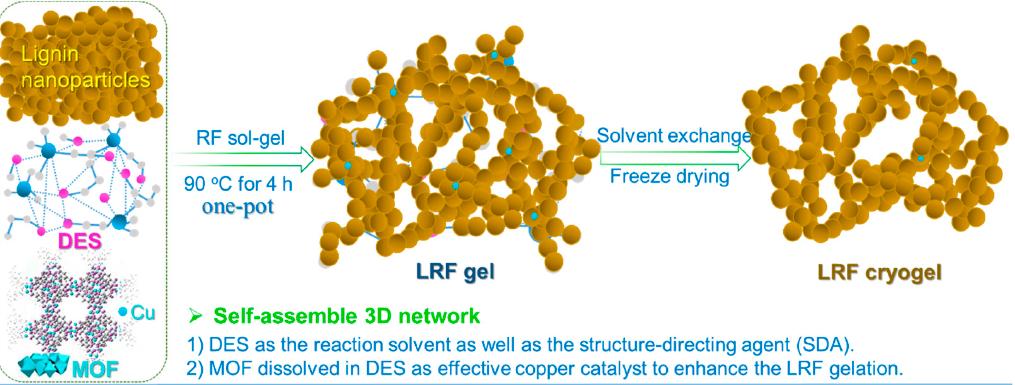
Figure 2. Typical SEM images of the LRF cryogels doped by MOF at DES1:5 (10 µm and 1